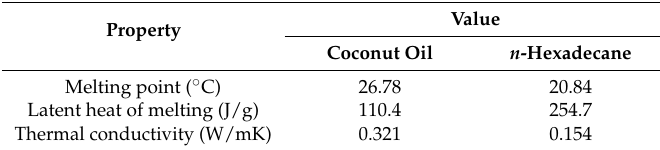
Table 1. Physical properties of coconut oil and n -hexadecane [23,24].